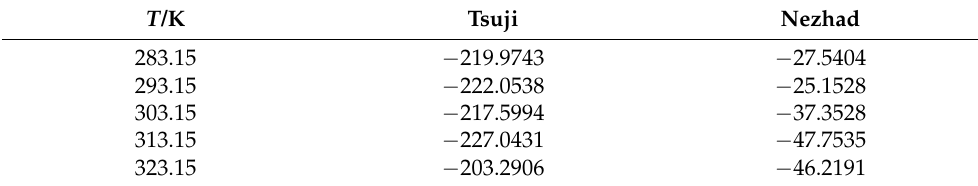
Table 11. Calculation results of AIC value of phenylglycine correlation solubility and pH model.